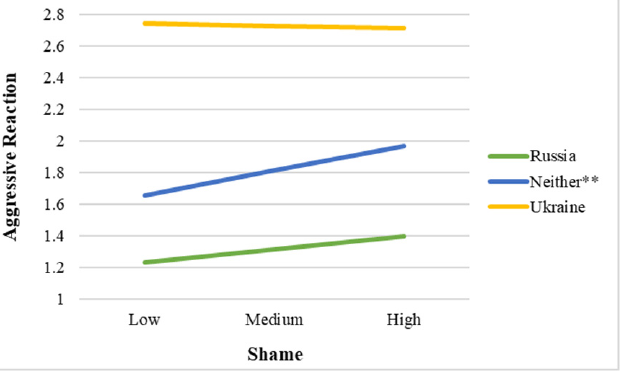
Figure A5. Plot of the relationship between Cognitive Reappraisal and Shame at low ( − 1 SD), medium (mean), and high (+1 SD) Appraisal of Own Emotion score; * = p < 0.05.